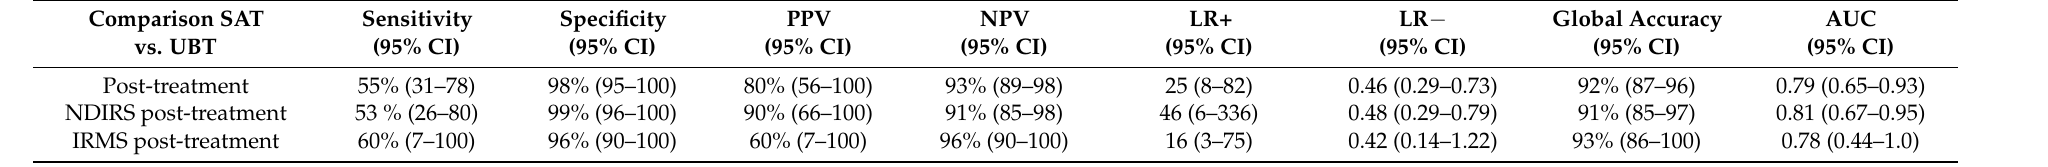
Table 3. Accuracy of the LIAISON ® Meridian H. pylori SA test in post-treatment patients. Comparison SAT